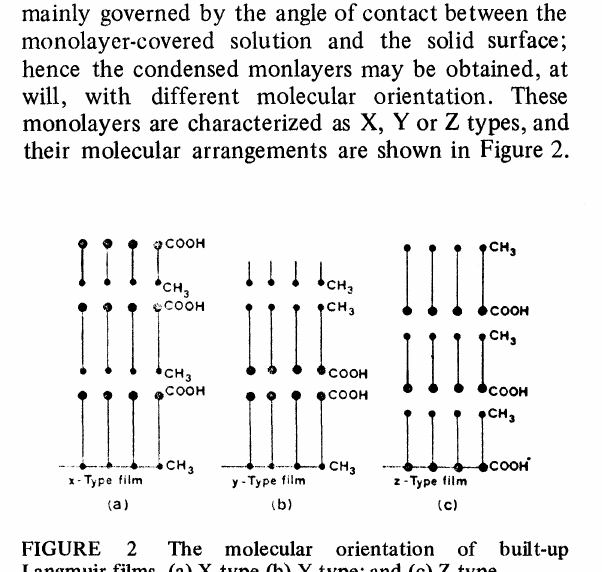
2 The molecular orientation of built-up Langmuir films. (a) X type (b) Y type; and (c) Z